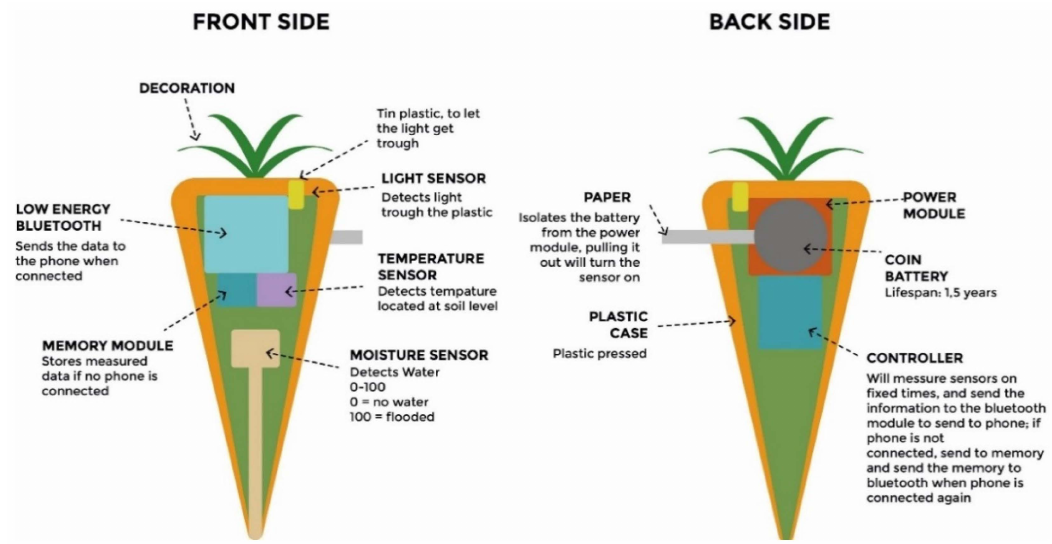
Figure 5. Sensors’ technical